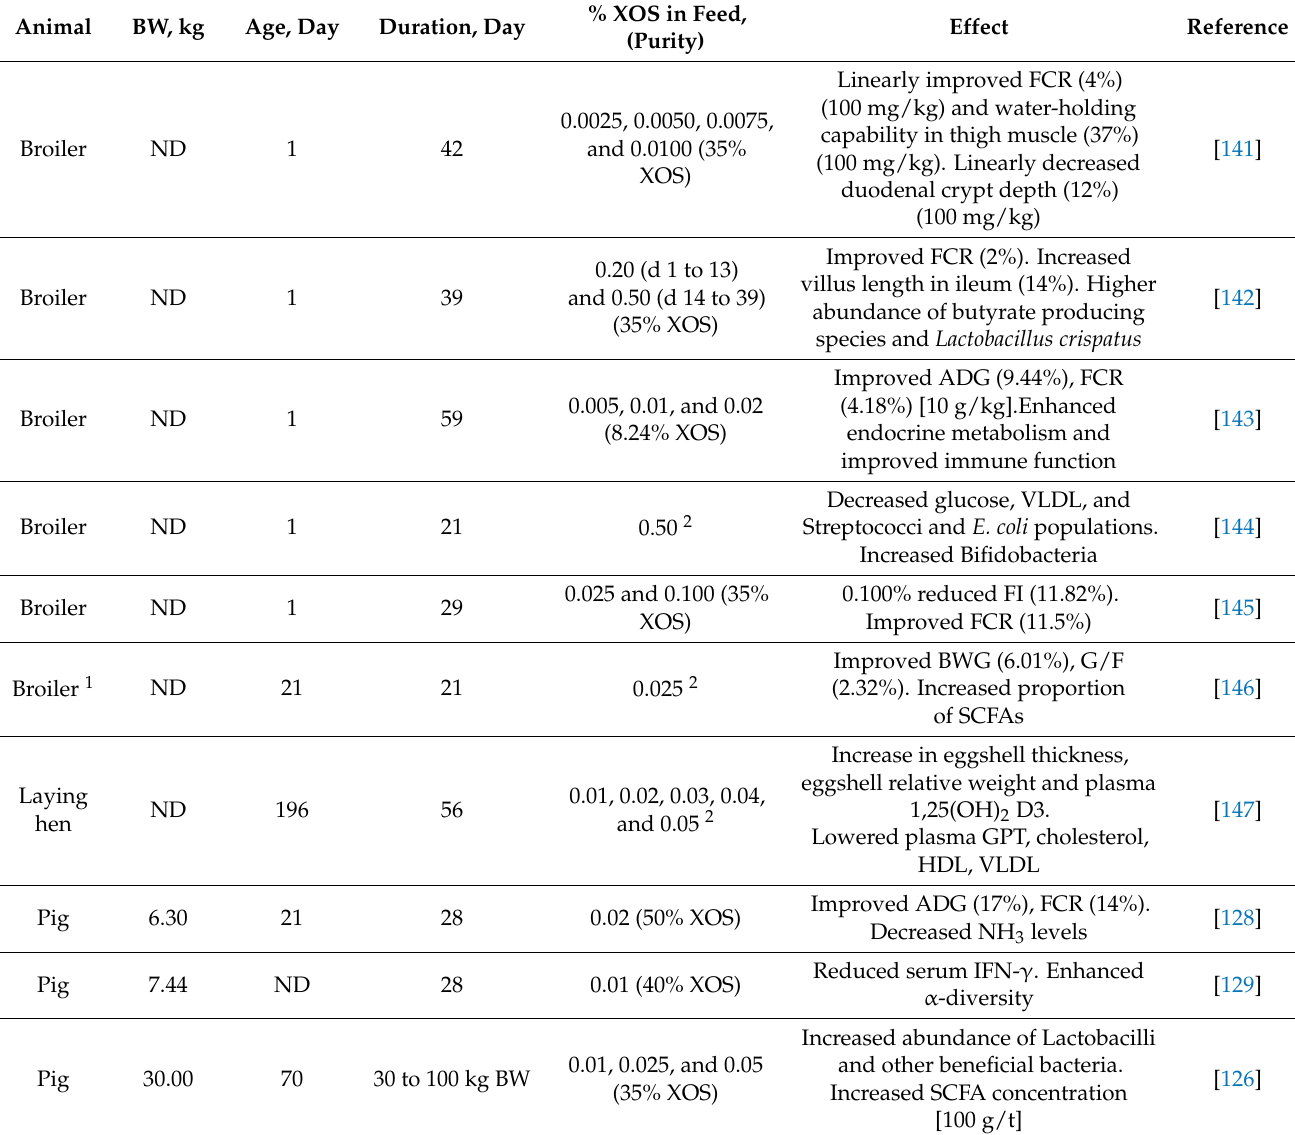
Table 3. Effects of the addition of xylooligosaccharide (XOS) to swine and poultry feeds.